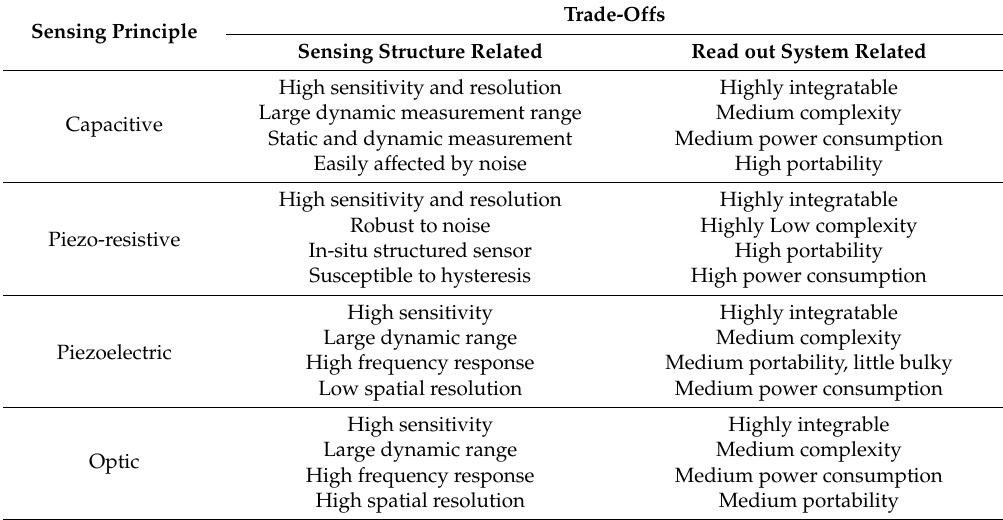
Table 1. Trade-offs of different sensing